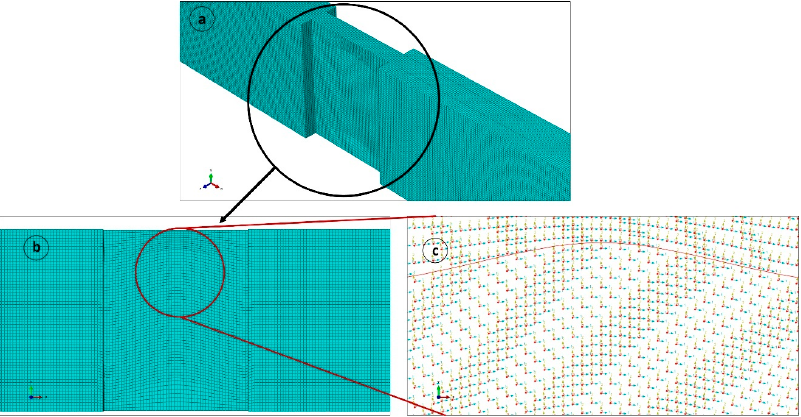
Figure 3. ( a ) Abaqus model with closely packed mesh, ( b ) mesh flow in the gage area along the waviness path, and ( c ) element orientation in the waviness region.